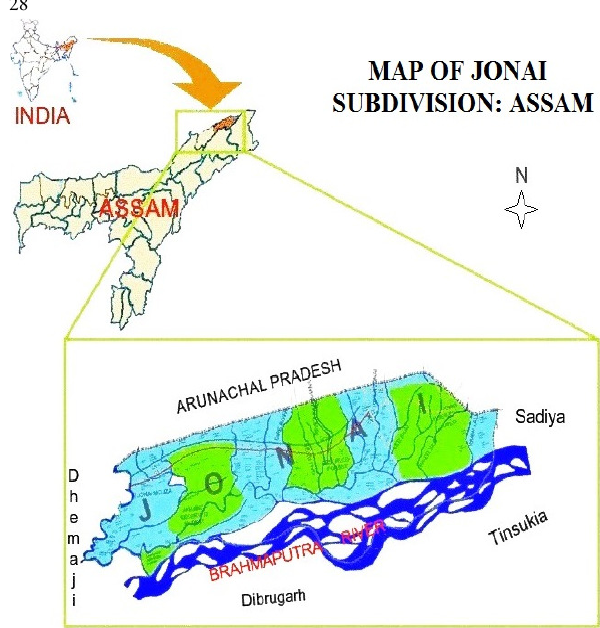
Fig. 1. Map of the study area